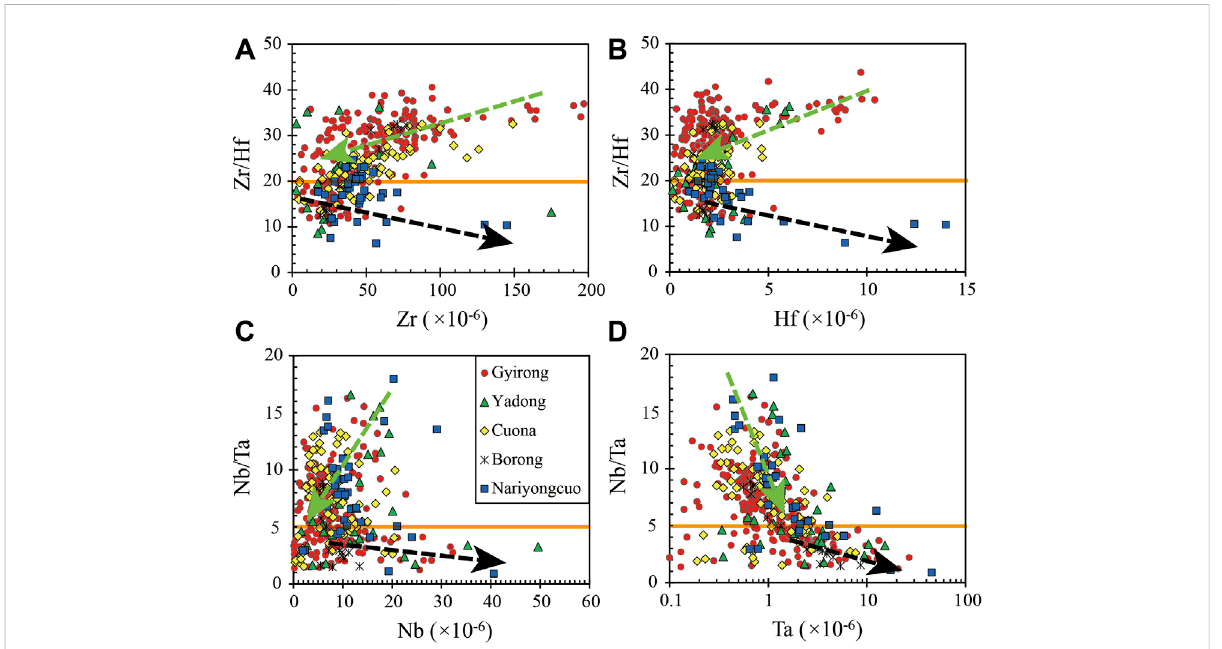
FIGURE 3 Systematic relationship between high- fi eld strength elemental concentrations and ratios in the silica magmas. (A) Zr-Zr/Hf, (B) Hf-Zr/Hf, (C) Nb-Nb/Ta, (D)